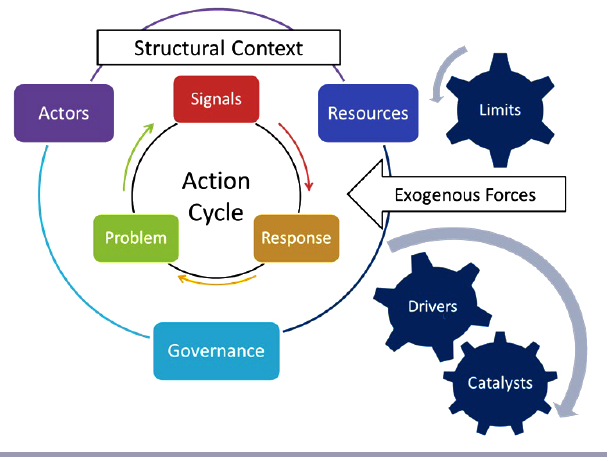
Fig. 2 . The action/structure